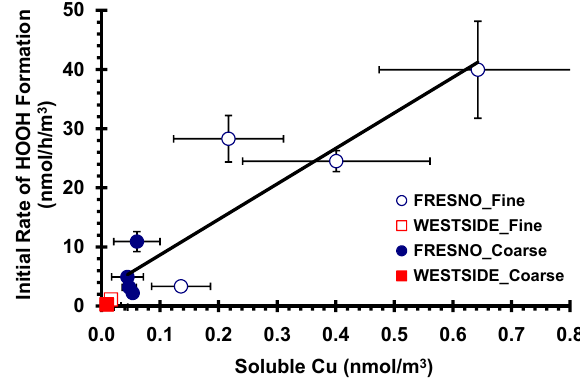
Fig. 6. Correlation between the air-volume-normalized initial rate of HOOH generation in SLF with Asc and the SLF-soluble Cu con- Figure 6 centration in corresponding PM extracts. Values are means ± SD, n = 3 for the HOOH rate, n = 4 to 6 for the Cu concentration. The initial rates of HOOH formation by Fresno fine and coarse PM were strongly correlated with the SLF-soluble Cu concentrations in cor- responding PM extracts: y = 60 x + 2 . 66, R 2 = 0 . 82. No correlation was observed between the SLF-soluble Cu concentrations and the initial rates of HOOH formation from the Westside PM ( R 2 = 0 .